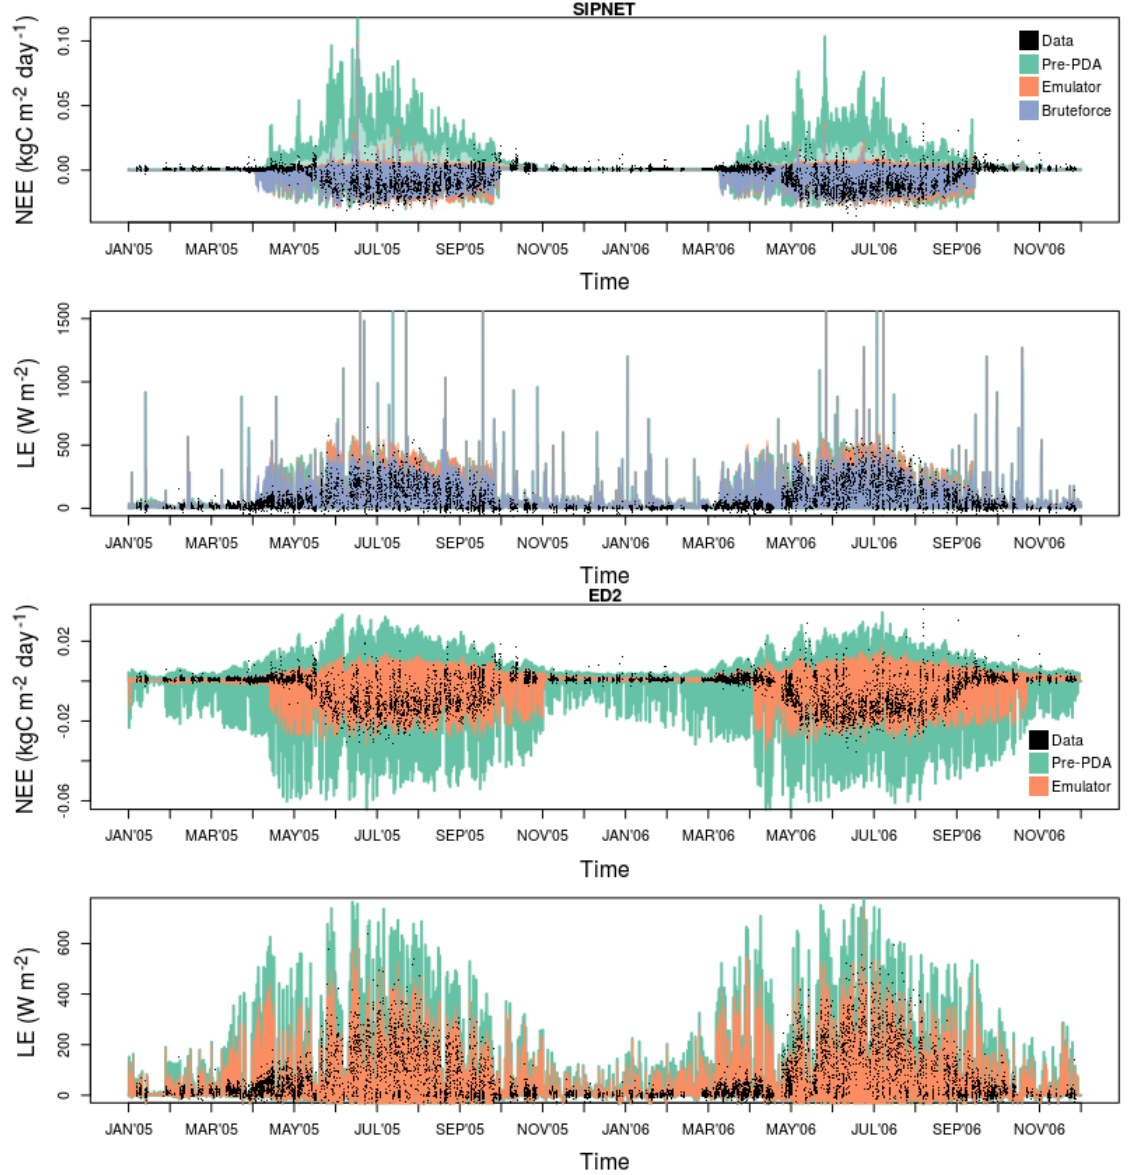
Figure A1. Unsmoothed, half-hourly time series comparison for NEE and LE predictions, before and after calibration.